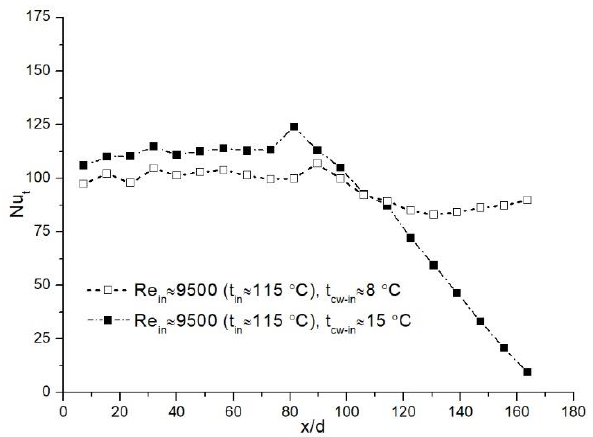
Figure 10. Distribution of the Nu t in the heat exchanger at Re in ≈ 9500 and at different cooling water inlet temperatures.